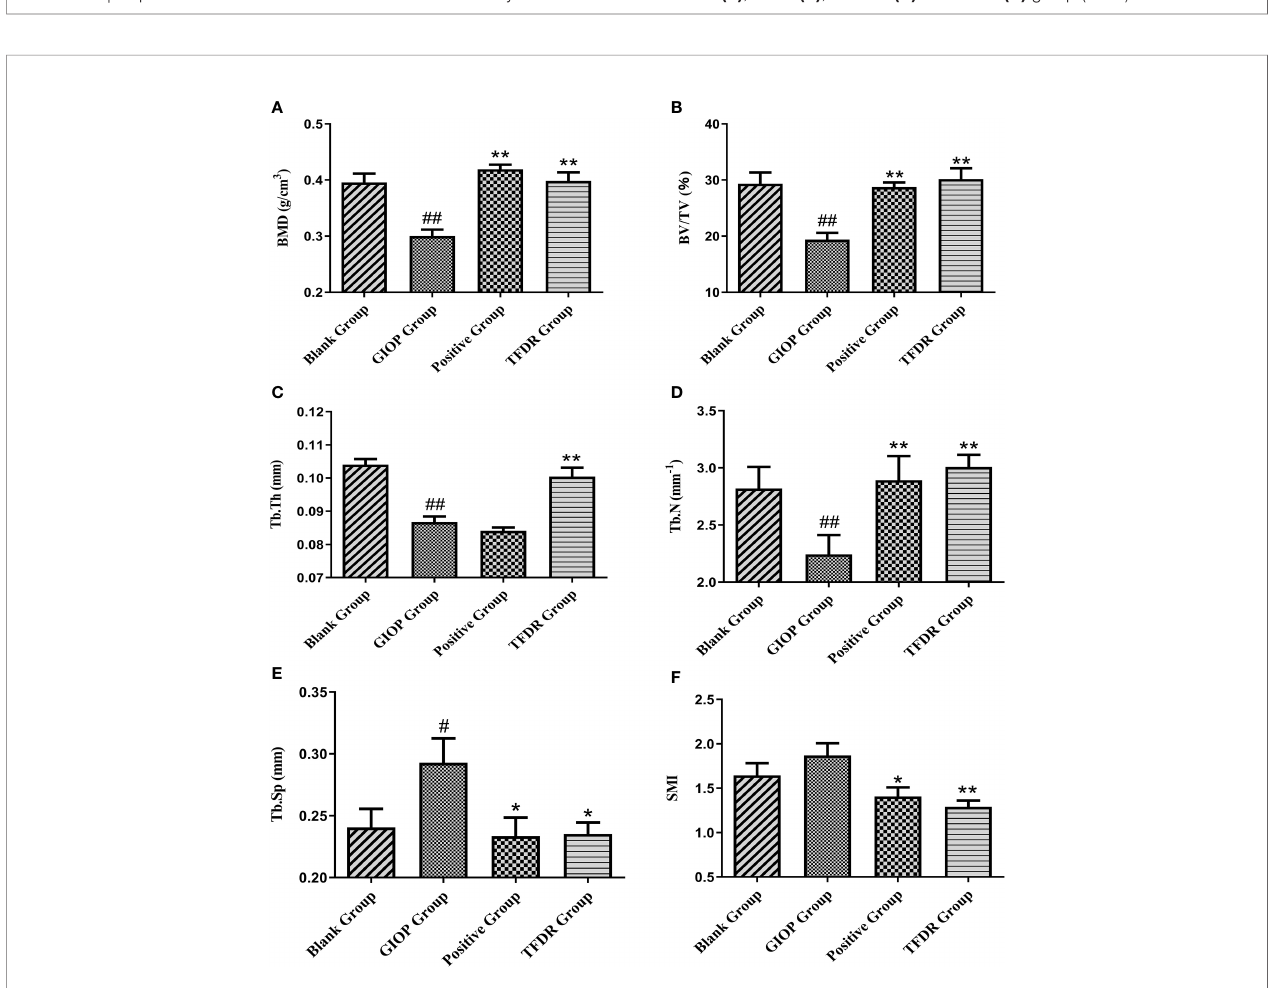
FIGURE 10 | The changes of bone parameters including bone mineral density (BMD) (A) , bone value/total value (BV/TV) (B) , trabecular thickness (Tb.Th) (C) , trabecular number (Tb.N) (D) , trabecular spacing (Tb.Sp) (E) and structural model index (SMI) (F) . Data are expressed as mean ± SEM. *p < 0.05 and **p < 0.01 vs. GIOP group rats; # p < 0.05 and ## p < 0.01 vs. blank group rats (n =